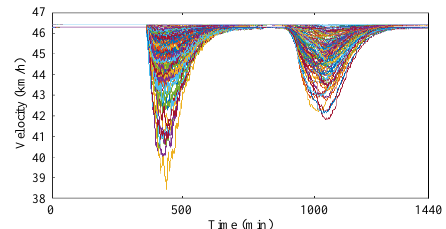
Figure 3. Road network model and EVCS location.